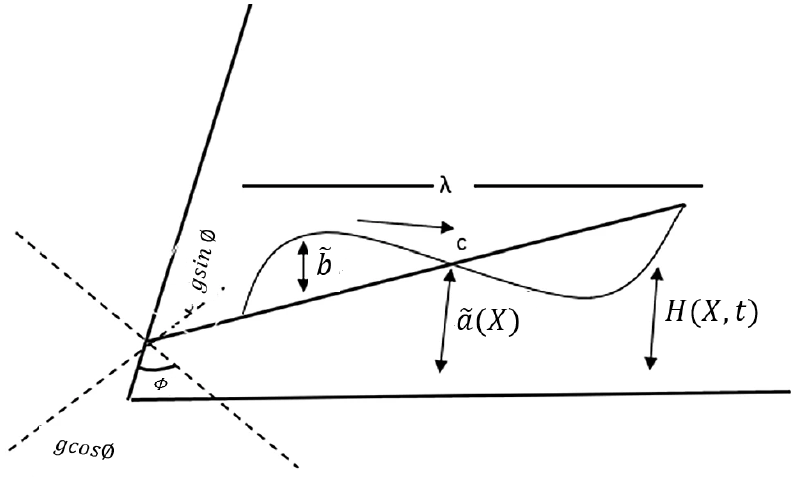
Figure 1. The geometry of the problem.